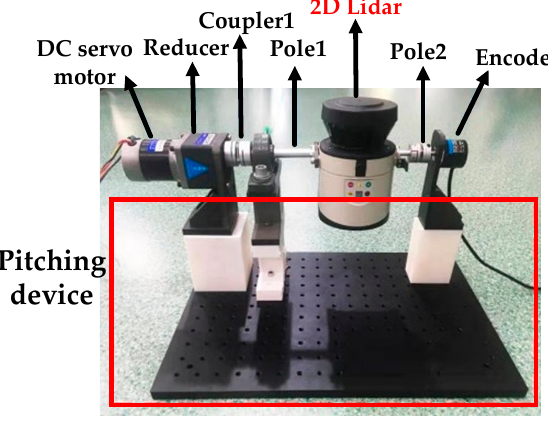
Figure 1. 3D Laser scanning system.